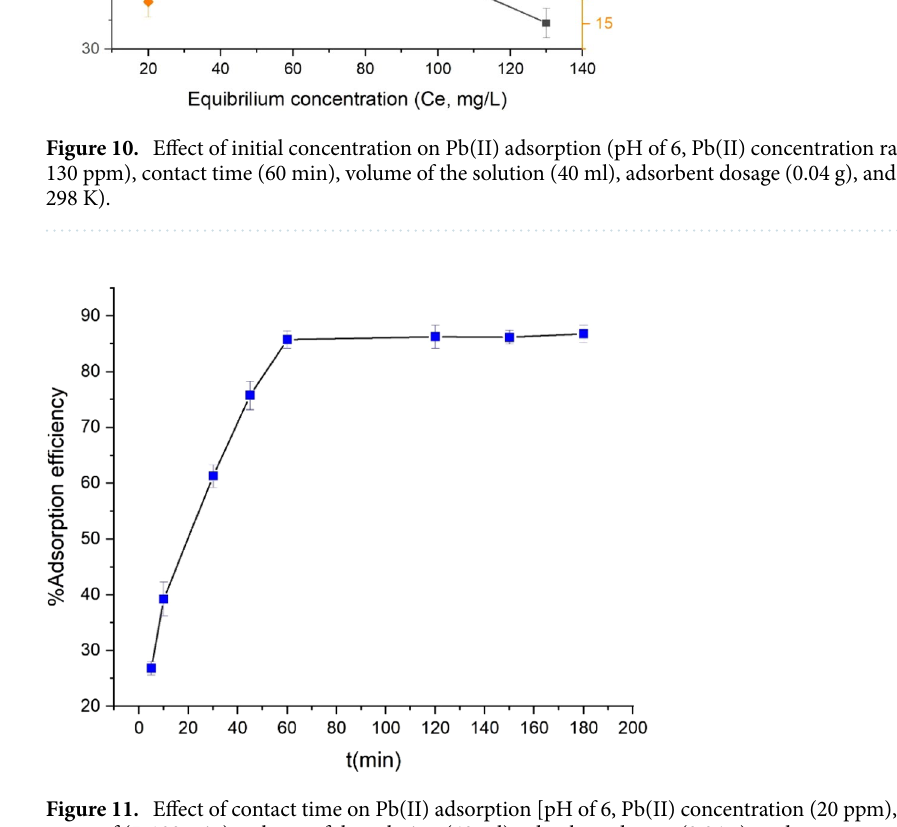
Figure 11. Effect of contact time on Pb(II) adsorption [pH of 6, Pb(II) concentration (20 ppm), contact time range of (5-180 min), volume of the solution (40 ml), adsorbent dosage (0.04 g), and temperature of 298